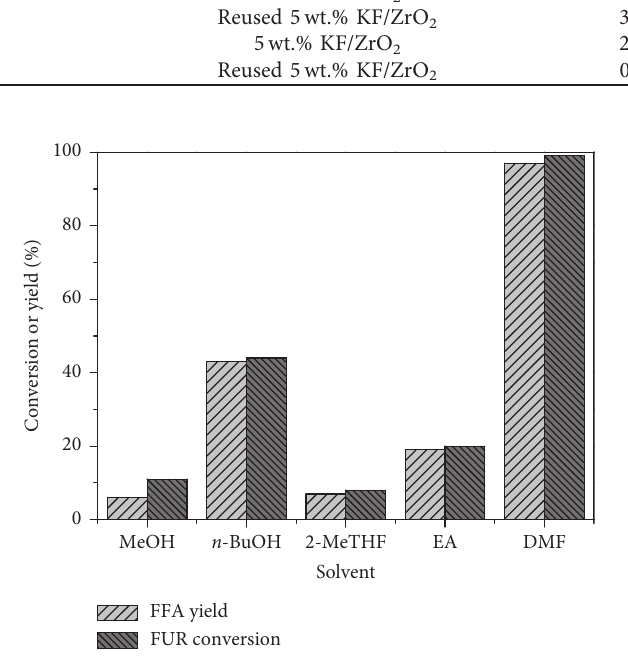
Figure 6: Influence of solvent type on the hydrogenation of FUR to FFA. Reaction conditions: 0.5mmol FUR, 25mg 5wt.% KF/ZrO equiv. H − of PMHS, 2mL solvent, 25 ° C, and 30min. DMF: N , N -dimethylformamide; EA: ethyl acetate; 2-MeTHF: 2-methylfuran; MeOH: methanol; n -BuOH: n -butanol.